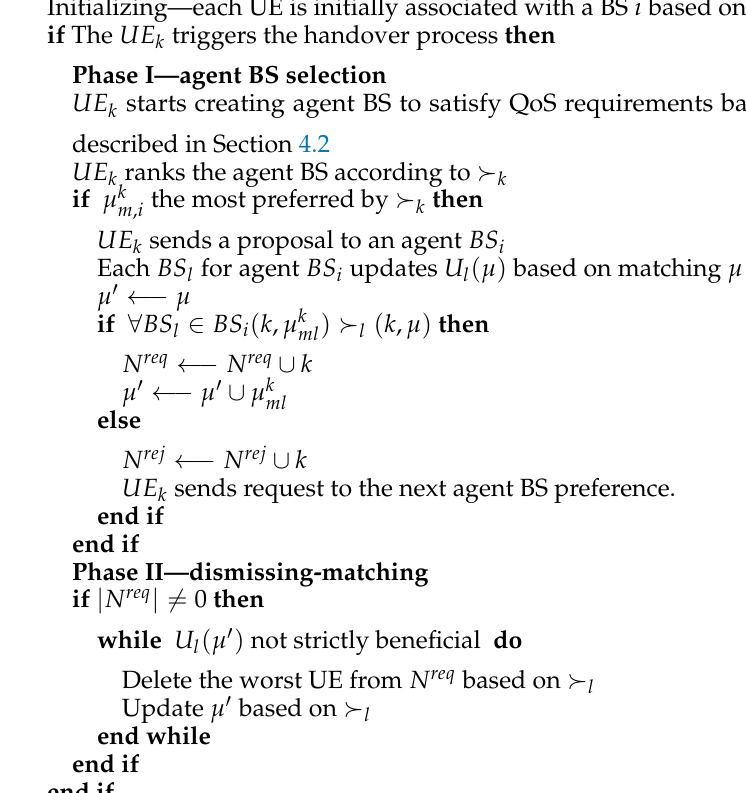
Algorithm 1 A context-aware handover